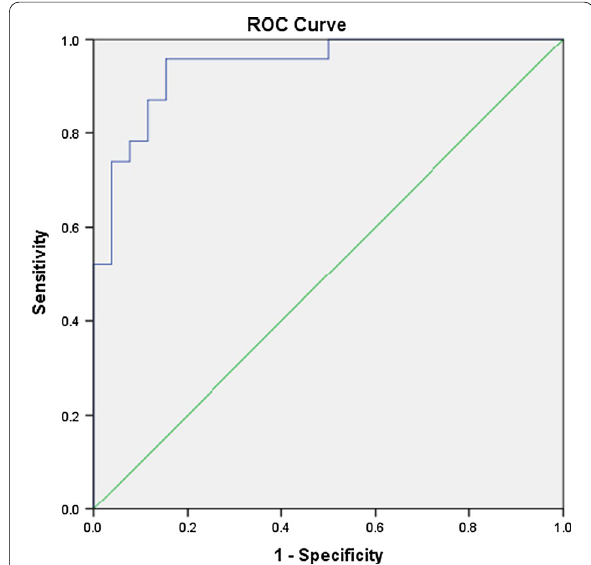
Fig. 1 ROC result of serum LTB4 level and painful diabetic neuropathy with AUC 84.2%